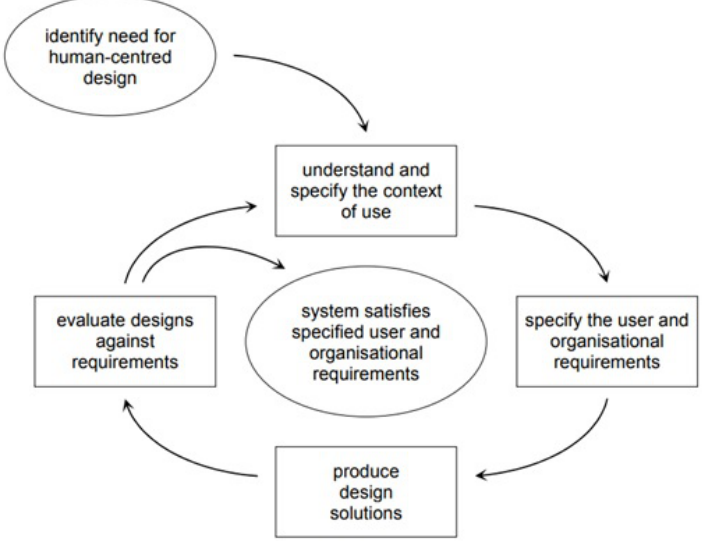
Figure 3. The process for human-centered design from Jokela et al. [51].